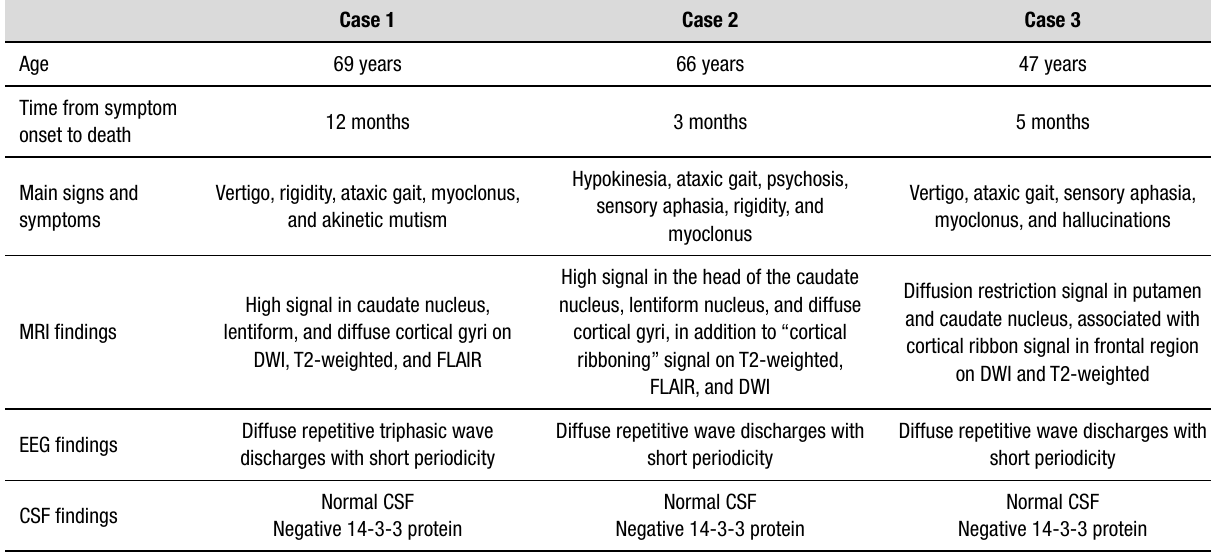
Table 1. Review of reported cases.